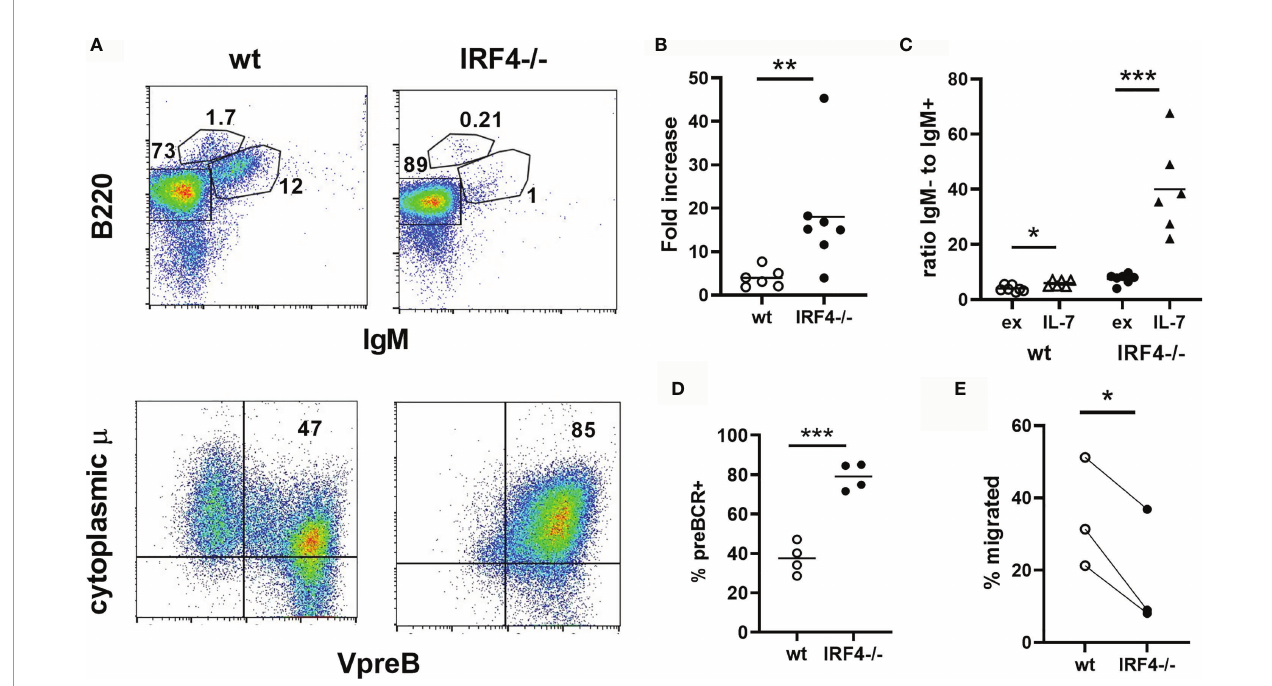
FIGURE 2 | Increased expansion and impaired differentiation of pre-B cells in IRF4-de fi cient IL-7 cultures. Bone marrow from wild type (open symbols) or IRF4- de fi cient ( fi lled symbols) BM was cultured in 10 ng/ml IL-7 for 5 days. (A) Cells were subsequently stained either extracellularly with antibodies against B220 and IgM (top, lymphocyte gate), or extracellularly with anti-B220 and intracellularly with anti-VpreB and anti-IgM heavy chain (bottom, B220+ gate). (B) The fold increase in the total number of B220+IgM- cells in IL-7 cultures relative to the input. Each symbol represents an individual mouse, the bar the mean. **p < 0.01 by Mann-Whitney test. (C) The ratio of B220+IgM- to immature B cells in ex vivo bone marrow (ex) and day 5 IL-7 cultures (IL-7) is indicated. Each symbol represents an individual mouse, the bar the mean. *p < 0.05, ***p < 0.001 by Student ’ s t-test. (D) The frequency of pre-BCR expressing (VpreB+cytoplasmic m +) cells among B220+ cells is indicated, gated as in (A) . Each symbol represents an individual mouse, the bar the mean. ***p < 0.001 by Student's t-test. (E) Cells from day 5 IL-7 cultures were plated in a transwell insert with 0.1ug/ml CXC12 in the bottom chamber. The percentage of B220+IgM- cells that migrated after 3.5 hrs is indicated. Each symbol represents an individual mouse, and each line connects results from an individual experiment. *p < 0.05 by paired